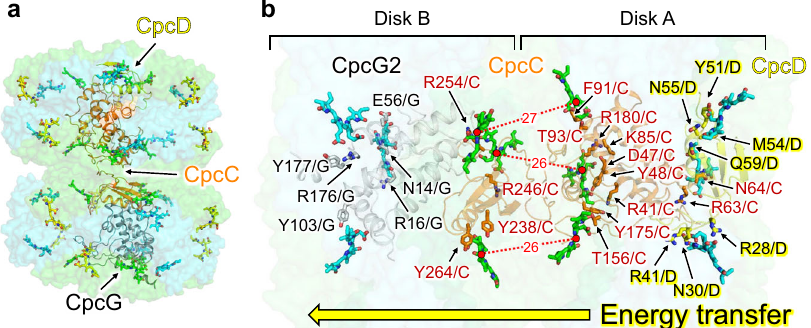
Fig. 8 Possible energy transfer pathway in the PC rod. a Arrangement of chromophores in the PC rod. α 84 , β 84 , and β 155 are colored cyan, green, and yellow, respectively. b Arrangement of β 84 s in a PC rod interacting with linker proteins. β 84 s at the boundary between Disk A and Disk B are colored green, and these chromophores are involved in the energy transfer between Disk A and Disk B. The amino acid residues of the linker proteins near β 84 s are indicated in